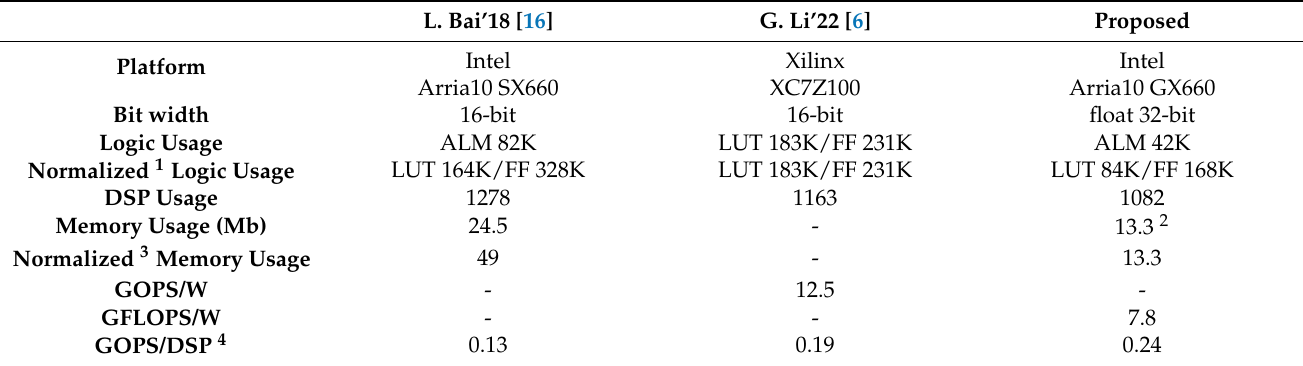
Table 4. Comparison of resource utilization with reference FPGA-based